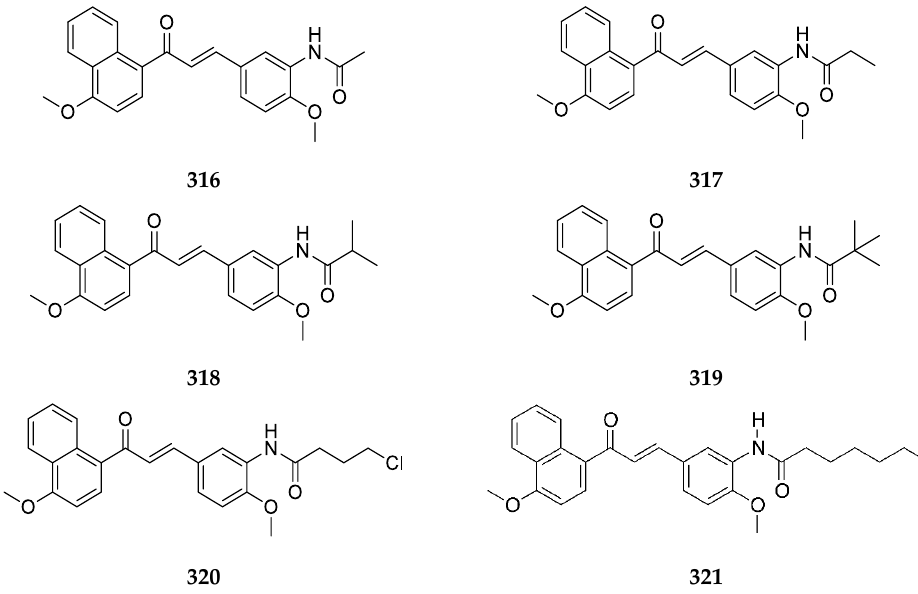
Figure 80. Chemical structure of N -acyl-3′-aminochalcone derivatives with substitution on rings A and B.